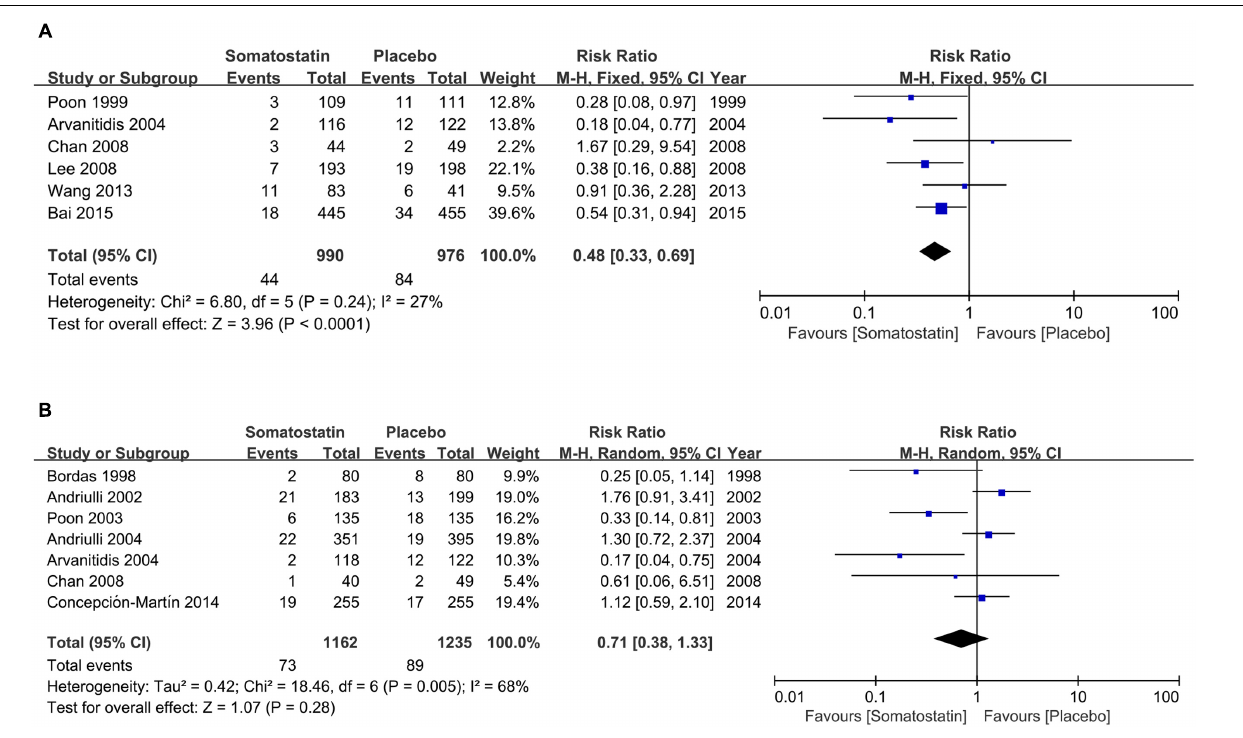
FIGURE 4 | Forest plot of RR of PEP when SOM was administrated at high ( ≥ 3000 µ g) (A) and low dose ( < 3000 µ g) (B) . I 2 and P is the criterion of heterogeneity test, (cid:7) pooled risk ratio, — (cid:4) — risk ratio and 95% CI.